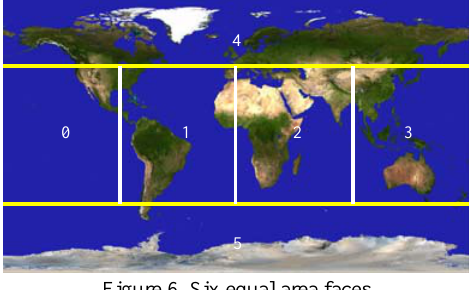
Figure 6. Six equal area faces The subdivision of sphere shell surface is based on partition curve. First, the sphere shell surface is considered as a normal sphere, it is divided into six approximately equal area faces, four faces along low latitude and two faces near north and south polar, the boundary (yellow line in Finger 6) is latitude ±45°. Second, the partition curve is constructed for each face. In Finger 7 and 8, the red lines are called b -curve, the green line is called l -curve, and three times subdivision of face 0 is shown.